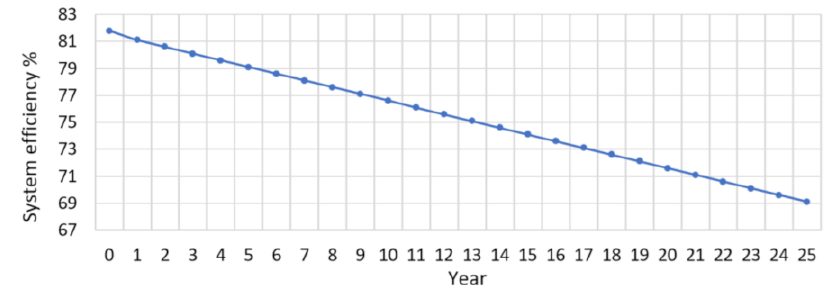
Figure 8. Decrease in efficiency over the life of the PV system (%)